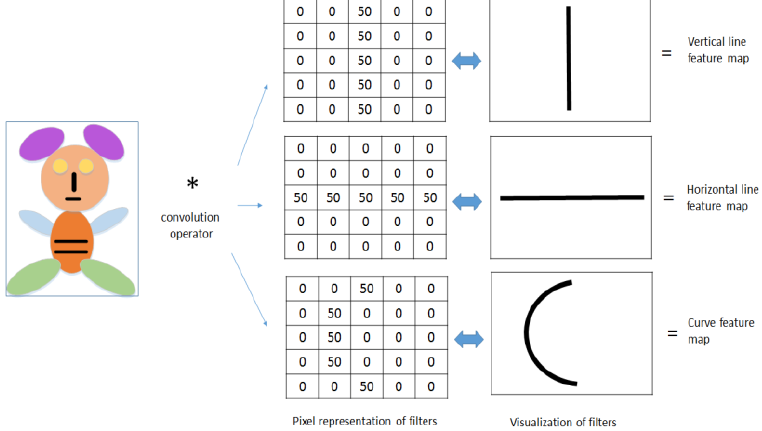
Figure 8. Pixel representation and visualization of filters.